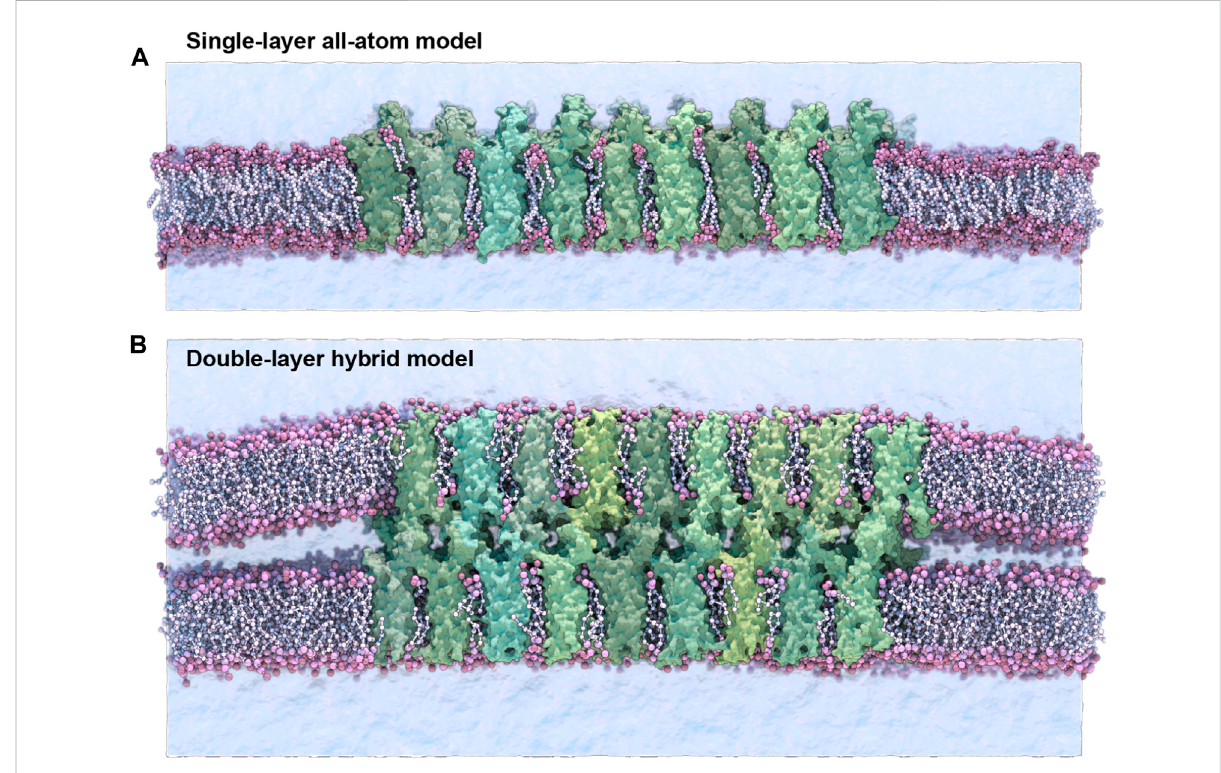
FIGURE 1 Single-layer and double-layer claudin-15 strands. (A) All-atom model of the single-layer claudin-15 strand in a single POPC lipid bilayer including 18 monomers (30 nm). (B) Double-layer claudin-15 strands embedded in two parallel POPC lipid bilayers represented at hybrid resolution with 36 monomers and 18 paracellular channels (30 nm). Additional systems of claudin-15 strands with 63 and 135 nm lengths were also